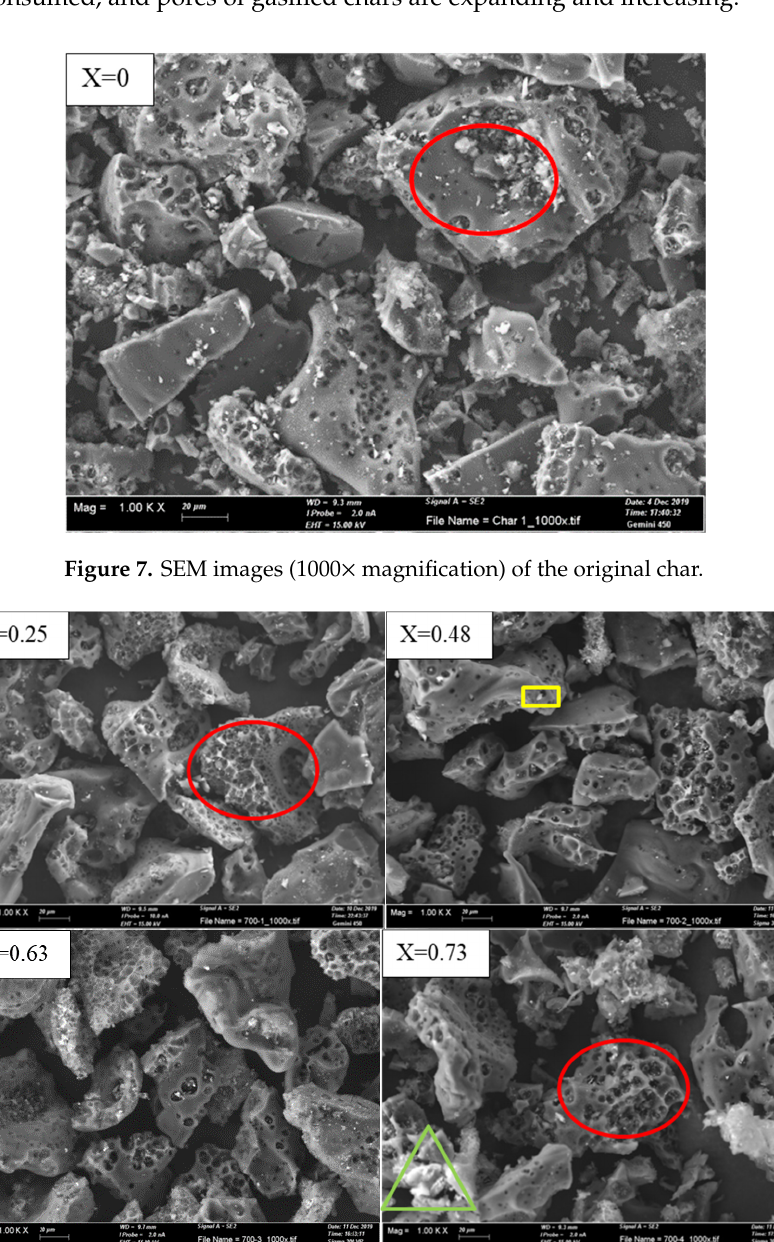
Figure 9. SEM images (1000× magnification) of char at different carbon conversions prepared from char gasification in H 2 O at 750 °C.